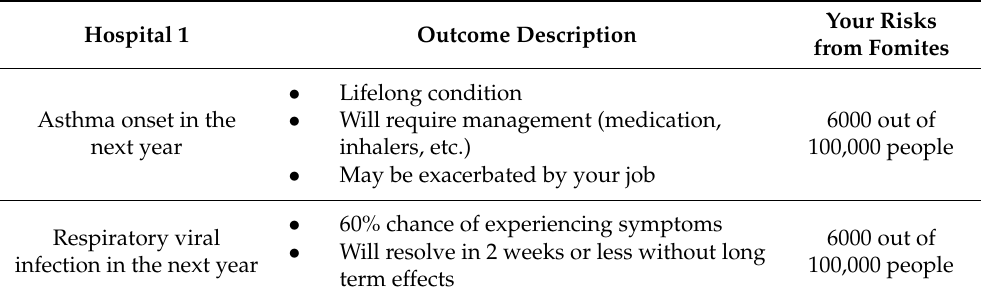
Table 1. Example of baseline risk (Hospital 1) table presented to participants (OA = Infect and Recover as an example).